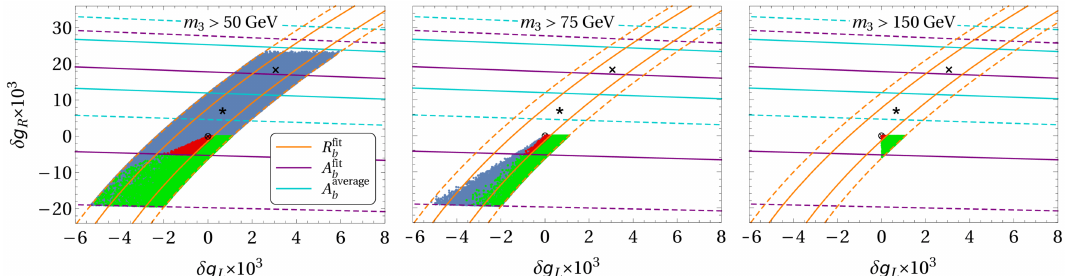
Figure 6 . Scatter plot of values of δg L and δg R in the aligned 2HDM. A crossed circle marks the point δg = δg = 0 . A star marks the best-fit point of solution 1 fit , and a cross the best-fit point L R of solution 1 average . The orange lines mark the 1 σ (full lines) and 2 σ (dashed lines) boundaries of the region determined by the experimental value (1.10a); similarly, the violet lines correspond to the value (1.10b) and the light-blue lines to the value (1.11). Red points agree with the 1 σ intervals (1.10); green points agree with the 2 σ , but not with the 1 σ , intervals (1.10); and blue points agree either with the 1 σ or the 2 σ intervals (1.10). Both the red and the green points satisfy the 1 σ limits in equation (3.16), while the blue points comply with laxer conditions where S can reach 2 σ bounds and T can reach 3 σ bounds in equation (3.16). Note that some blue points are underneath either red or green points. Left panel: both new neutral scalars have masses above 50 GeV; middle panel: both new neutral scalars have masses above 75 GeV; right panel: both new neutral scalars have masses above 150 GeV.